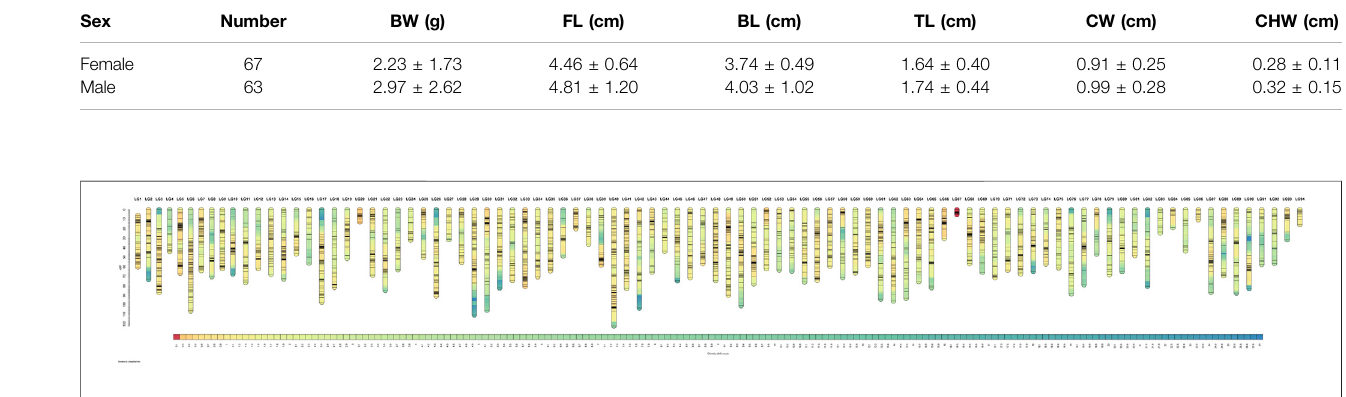
FIGURE 1 | Genetic lengths and marker distributions of 94 linkage groups in the linkage map of red swamp cray fi sh. The scaleplate on the left indicates genetic distance (centimorgan as the unit). The color module represents the SNP marker distribution density of each